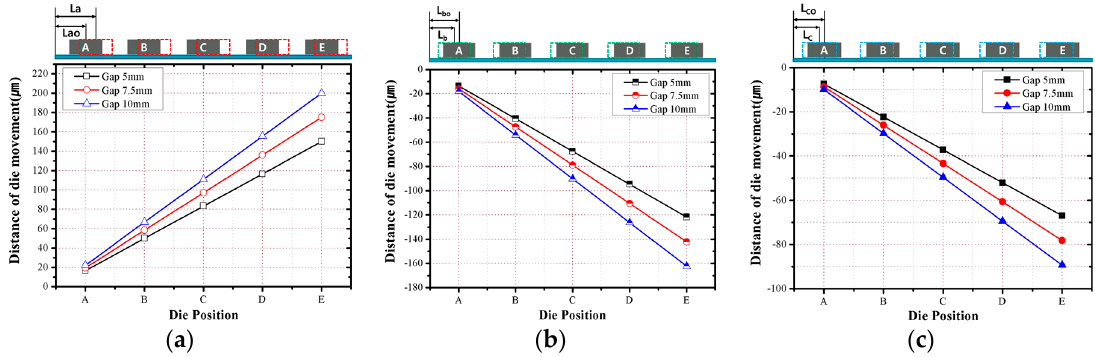
Figure 14. Evaluated die movement caused by thermal conditions: ( a ) thermal expansion during the molding process; ( b ) thermal contraction during the EMC curing process; ( c ) thermal contraction after the debonding process.